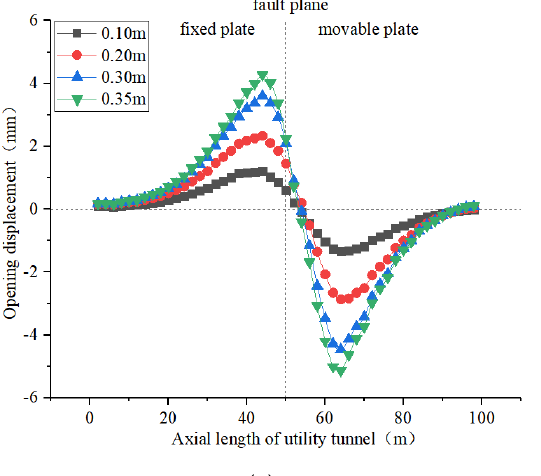
Figure 8. Distribution curves of the longitudinal horizontal opening displacement. ( a ) Roof ( b ) Floor.